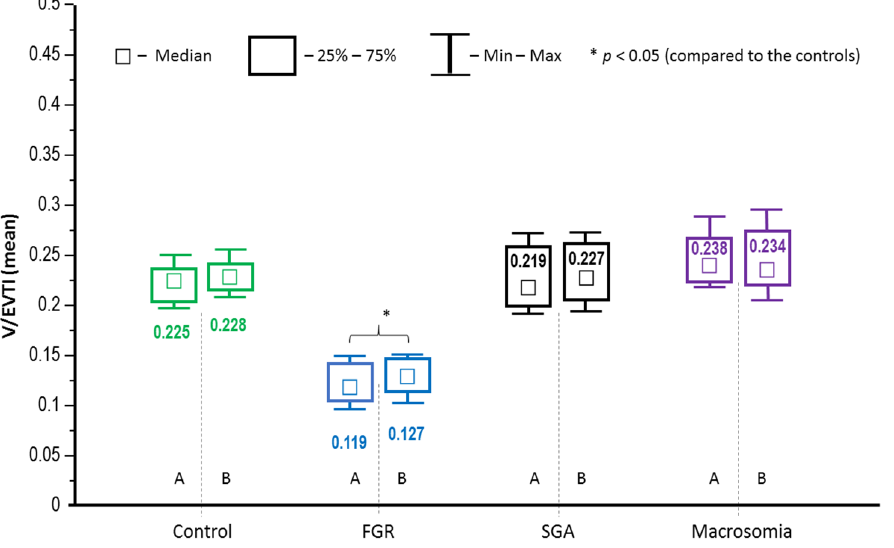
Figure 2. A comparative examination of microvessel density in the placental sections (A—central part, B—peripheral part of the placenta) using the vascular/extravascular tissular index (V/EVTI); the median values (abstract numbers) and IQR. FGR—foetal growth restriction; SGA—small-for- gestational-age.